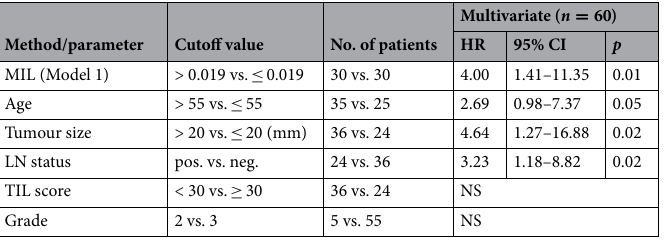
Table 3. Multivariate analysis for breast cancer specific survival of TNBC patients for Model 1 output on test and validation data. NS not significant.